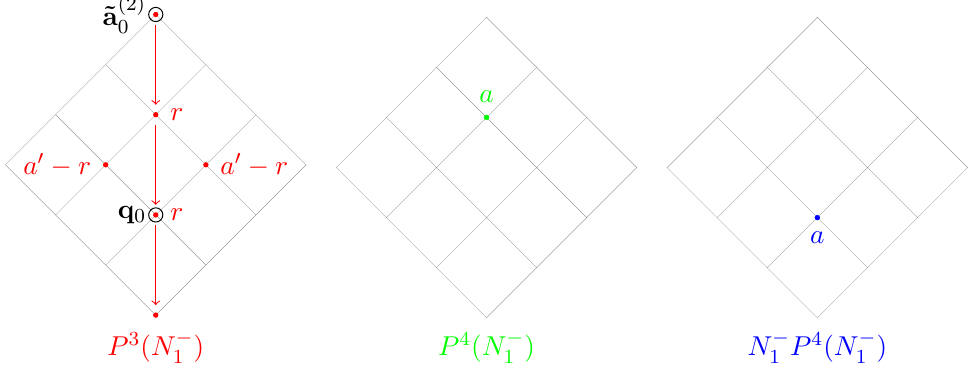
Figure 13 . The left picture shows a mixed Hodge structure, determined by some integer r (cid:21) 1, on P 3 ( N (cid:0) ). The middle picture shows a mixed Hodge structure on P 4 ( N (cid:0) 1 shows the image of the middle picture under the action of N (cid:0) arrows label the action of N (cid:0) . The colourings are in agreement with equation (4.38) and (cid:12)gure 12. 2 The sum of these three Hodge-Deligne diamonds is the diamond of mixed Hodge structure I p;q , of type IV d . The circles around the dots in the (cid:12)rst diamond indicate (2) the location of q 0 and ~a (2) 0